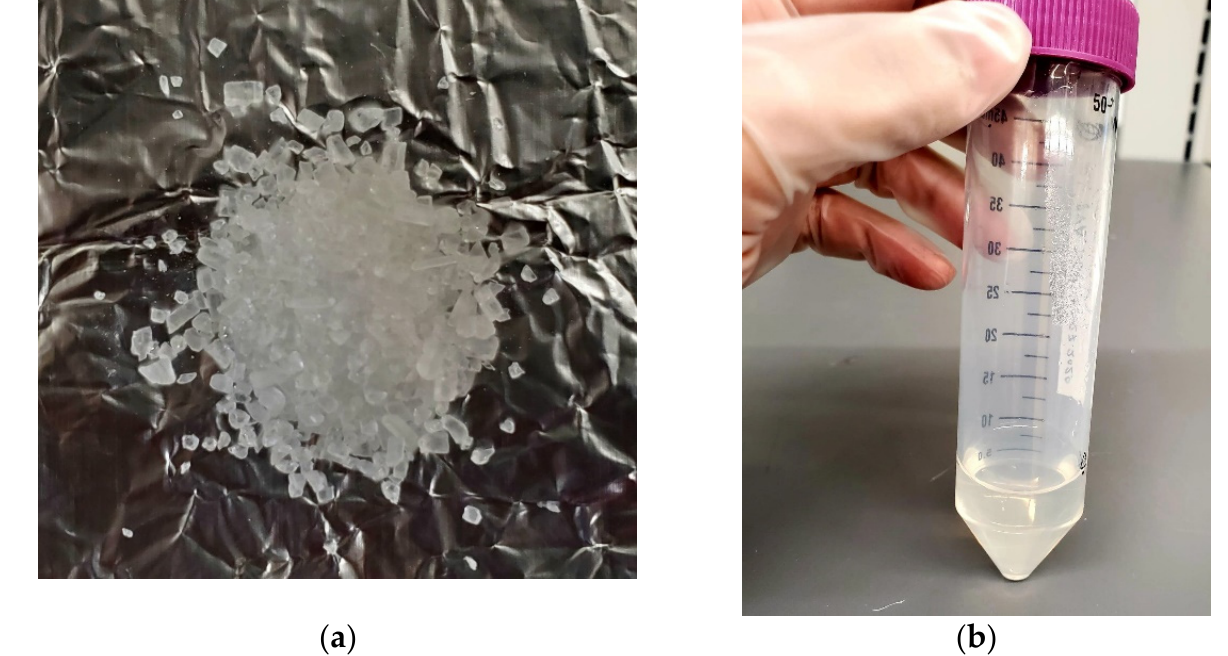
Table 1. Viscosity measurement of all five PVA